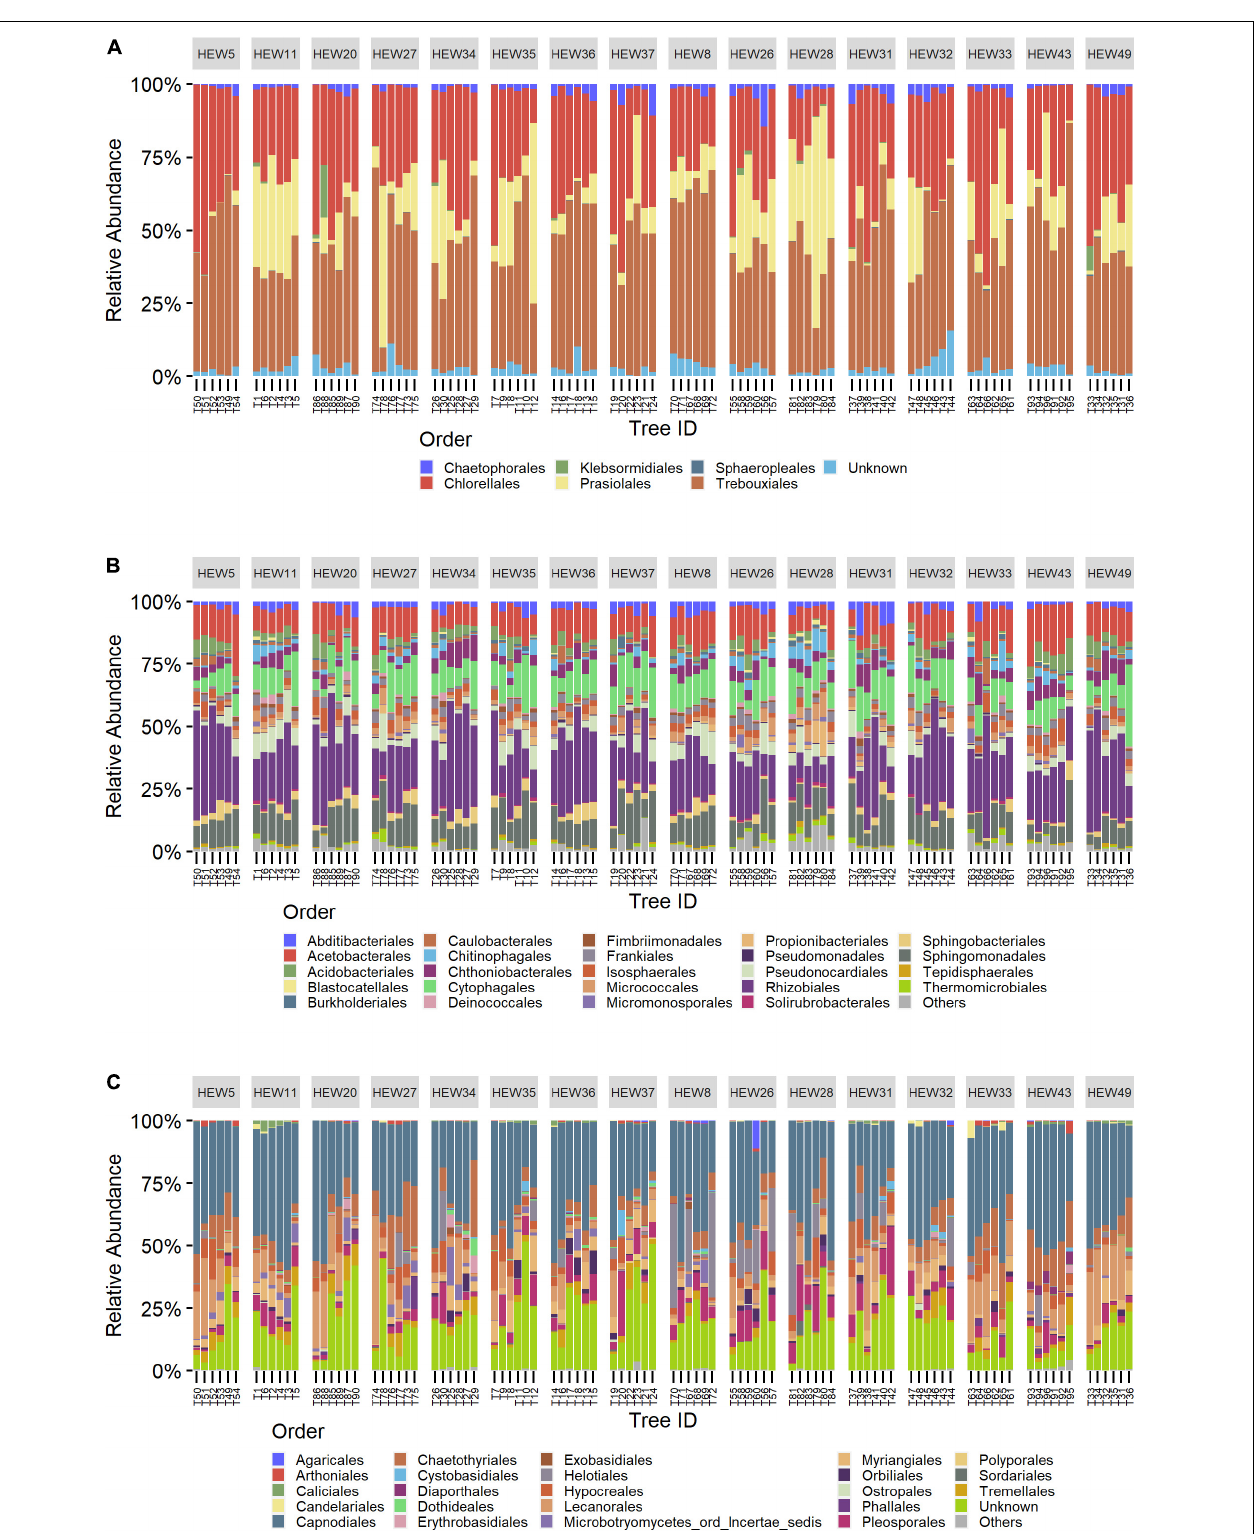
FIGURE 2 | Community bar charts showing the relative abundance of the 25 most abundant orders split by sampling plots for algae (A) , bacteria (B) and fungi (C) . From left to right: the first eight plots are under a low-, and the next eight under a high-management regime. Bars within plots represent individual trees, from large to small tree-size class (2 trees each), from left to